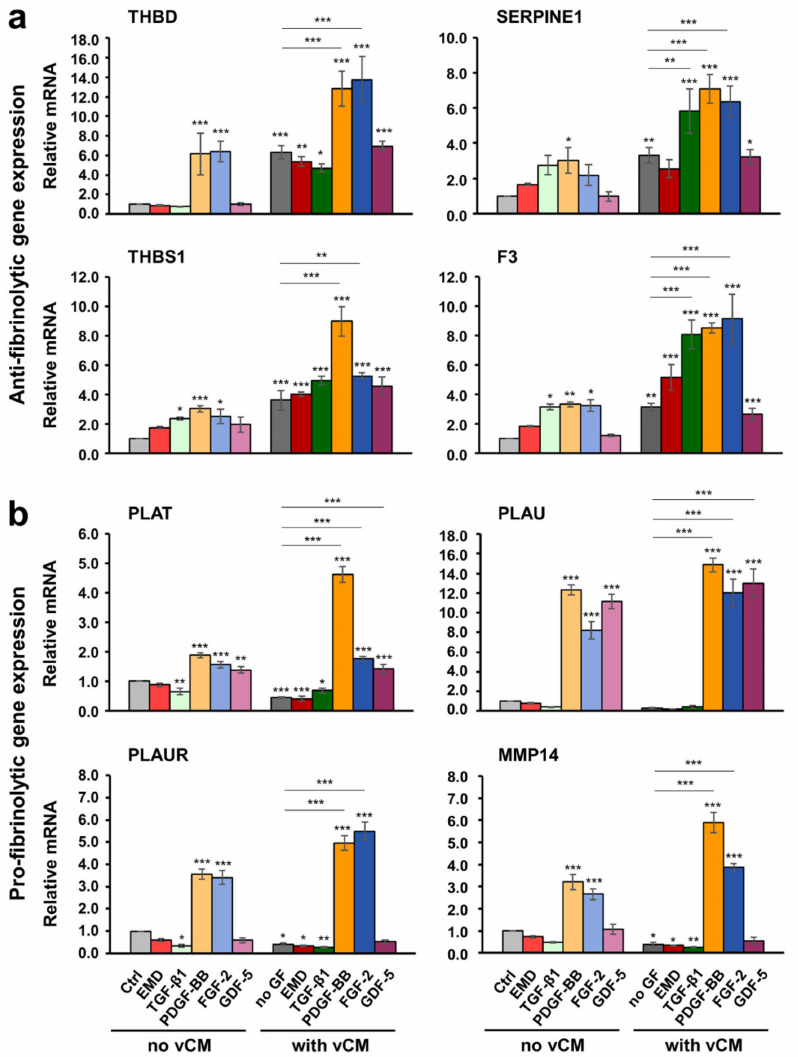
Figure 6. Effect of native/uncoated or growth factor-coated vCM on the anti- ( a ) and pro- fibrinolytic ( b ) gene expression in primary HUVECs. Cells were grown under each of the four experimental conditions described in Figure 3 before total RNA was extracted and analyzed by qRT-PCR for the expression of THBD, SERPINE1, THBS1, and F3 antifibrinolytic ( a ) as well as PLAT, PLAU, PLAUR, and MMP14 profibrinolytic ( b ) genes. Values normalized to GAPDH are expressed relative to the values of control cells (Ctrl) grown as described in Figure 3a. Means ± SD from three independent experiments and significant differences to the Ctrl unless otherwise indicated, *** p < 0.001, ** p < 0.01, * p < 0.05 are